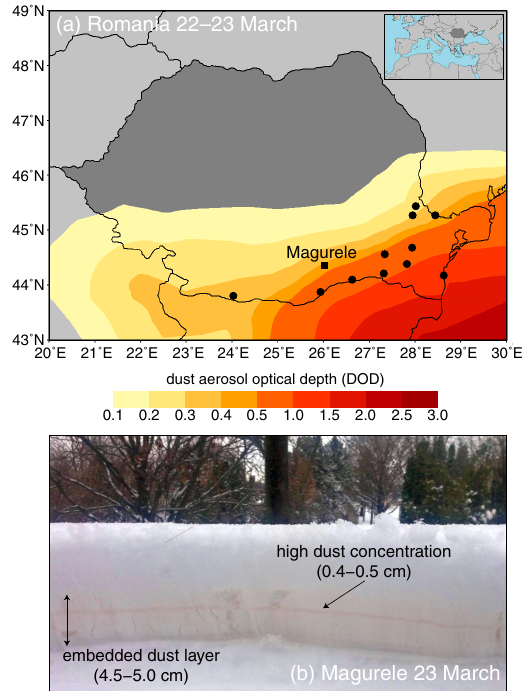
Figure 1. ( a ) Dust aerosol optical depth over Romania as derived from Copernicus Atmosphere Monitoring Service (CAMS) data, accumulated between 22 March 2100 UTC–23 March 0600 UTC, shaded according to the scale. The black circles represent the sites from which there was a visual confirmation of the dust present at the ground. The black square represents the location of the Romanian Atmospheric 3D Observatory (RADO, M˘agurele, Romania); ( b ) A section of the snow layer at RADO showing the embedded dust layer (the thickness of the embedded dust layer is indicated together with the thickness of the high dust concentration